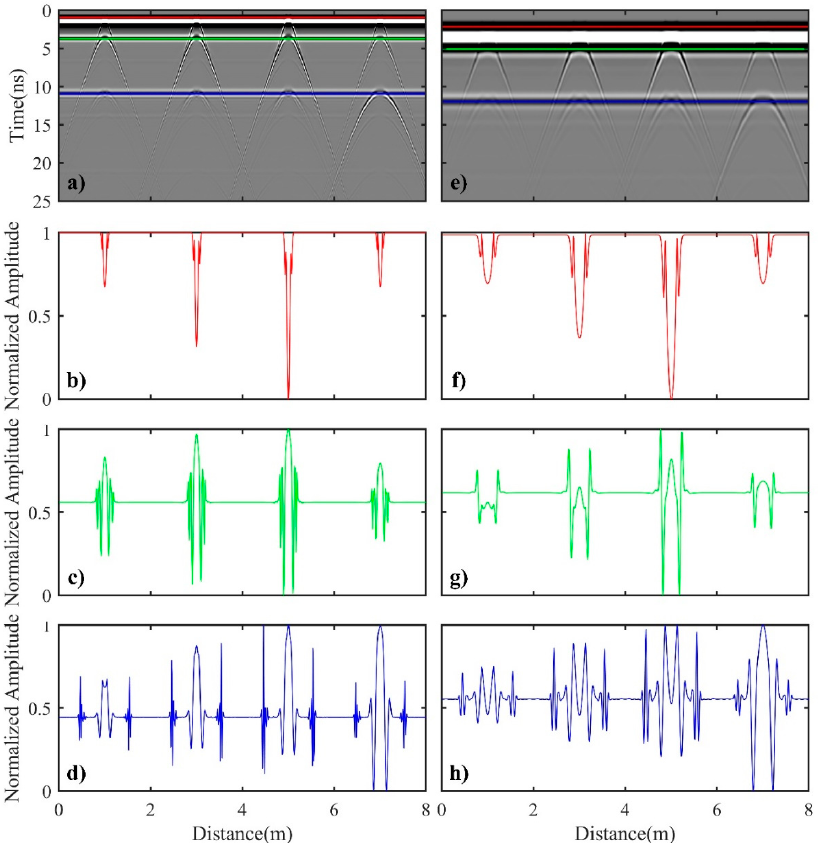
Figure 7. Simulated GPR profiles of Model 7 using the center frequencies of ( a ) 900 MHz and ( e ) 400 MHz. The red, green and blue lines in ( a ) and ( e ) represent the amplitude curves of the corresponding direct ground waves, reflected waves of the second and third interface, respectively. ( b ), ( c ) and ( d ) the normalized forms of the red, green and blue lines in ( a ), respectively, while ( f ), ( g ) and ( h ) the normalized forms of the red, green and blue lines in ( e ), respectively.